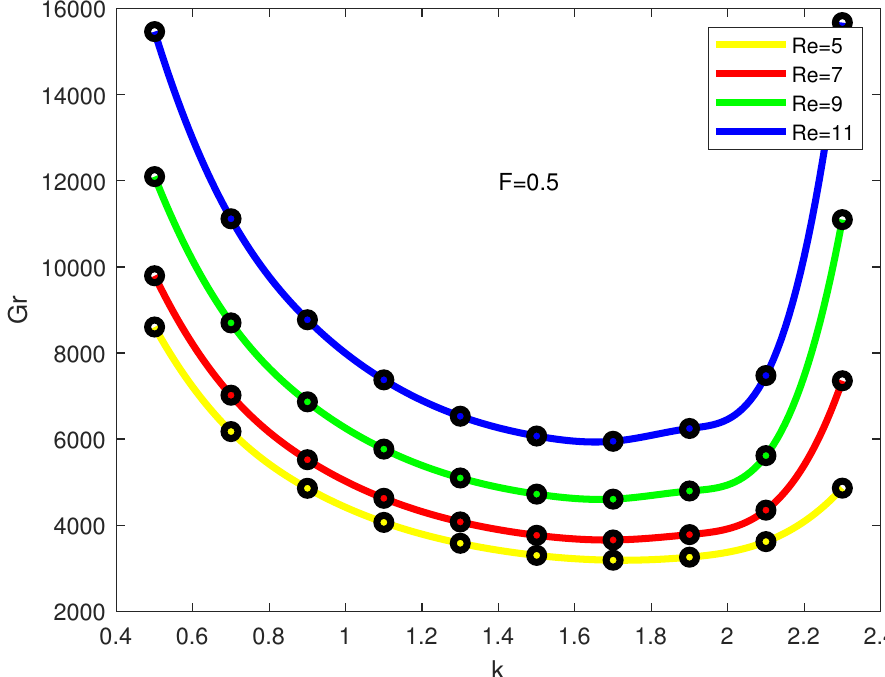
Figure 5. Marginal stability curves for F = 0.5 and η = 0.6 (the Reynolds numbers are in the range 5 ≤ Re ≤